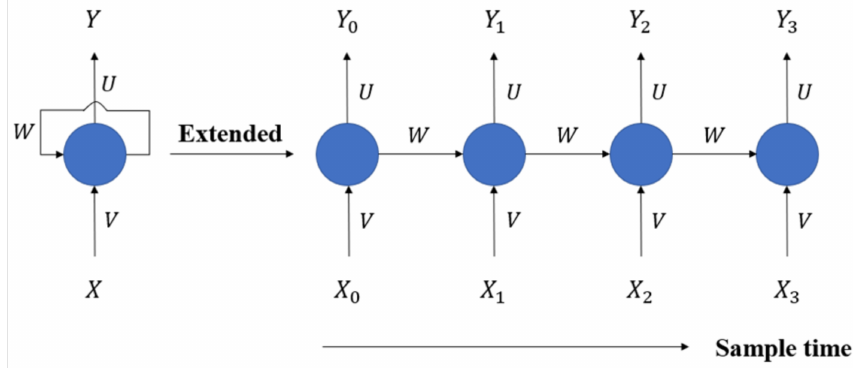
Figure 2. RNN neuron ( left ) unrolled in time axis ( right